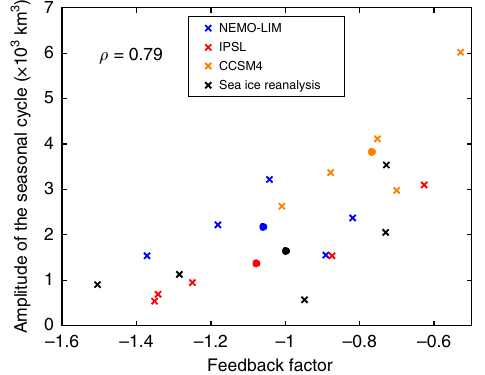
Fig. 4 Amplitude of the sea ice volume seasonal cycle versus the ice production-entrainment feedback factor. The ice production-entrainment feedback factor γ θ is de fi ned as the ratio of the melting due to warm water entrainment to the initial ice formation 50 . The values are estimated over 1990 – 2005 for a standardized perturbation corresponding to an increase of 10 cm of sea ice. For both observational and model datasets, the evaluation of γ θ is performed on the basis of temperature and salinity pro fi les in the Southern Ocean, averaged over January – February for the period 1990 – 2005. Values are represented by fi ve crosses corresponding to fi ve sectors of the Southern Ocean 111 . Results for NEMO-LIM 112 , CCSM4 113 , and IPSL 114 models are in colors. Estimates are given in black based on oceanic observations 115 and the sea ice volume derived from a reanalysis 116 . For all datasets, the plain circles correspond to the average of γ θ and of the amplitude of the ice volume seasonal cycle over all sectors, and ρ is the correlation coef fi cient between these two